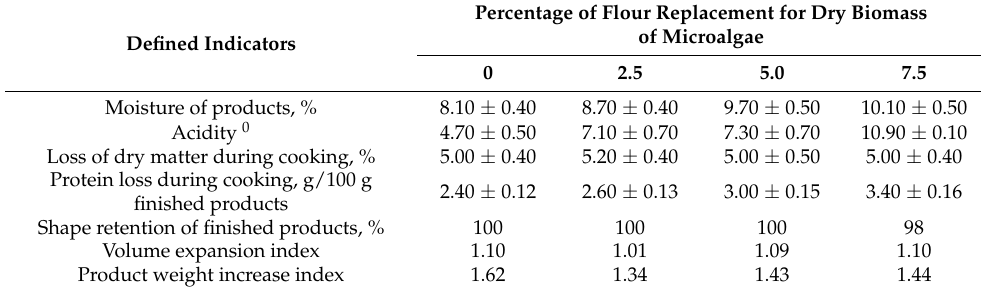
Table 6. Physical and chemical indicators of the quality of pasta with the addition of microalgae C. sorokiniana dry biomass.